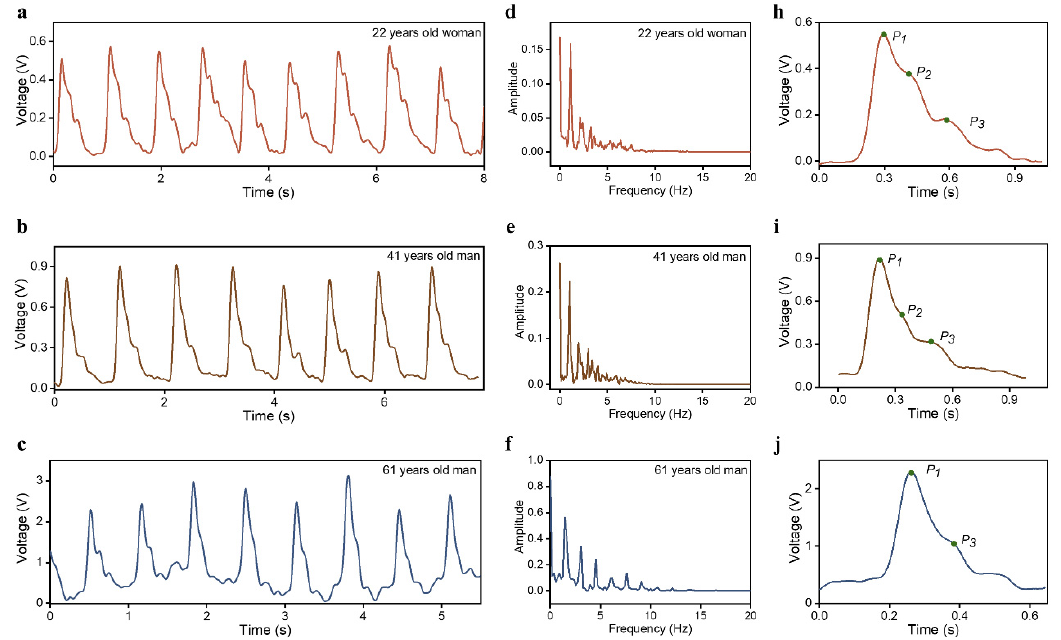
Figure 5. The pulse waves of different subjects: ( a – c ) a 22-year-old woman, a 41-year-old man, and a 61-year-old man; ( d – f ) the spectrum of pulse signals of different subjects; and ( h – j ) an enlarged view of one cycle of pulse waves of different subjects.